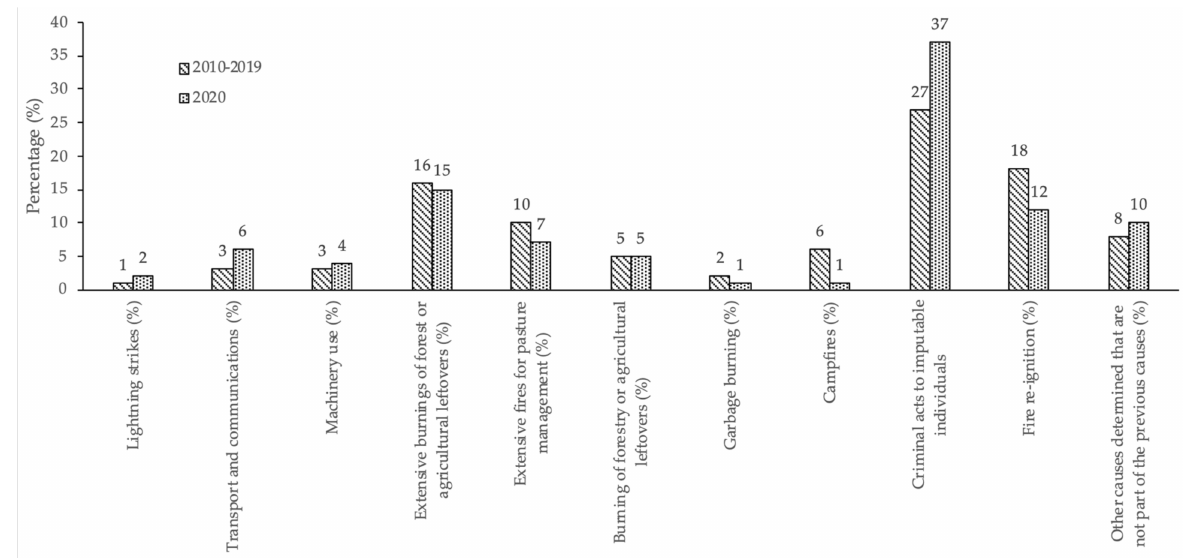
Figure 1. Frequent causes of rural fires in Portugal (data collected from http://www.icnf.pt/portal/florestas/dfci/relat/ rel-if/2020, accessed on 12 January